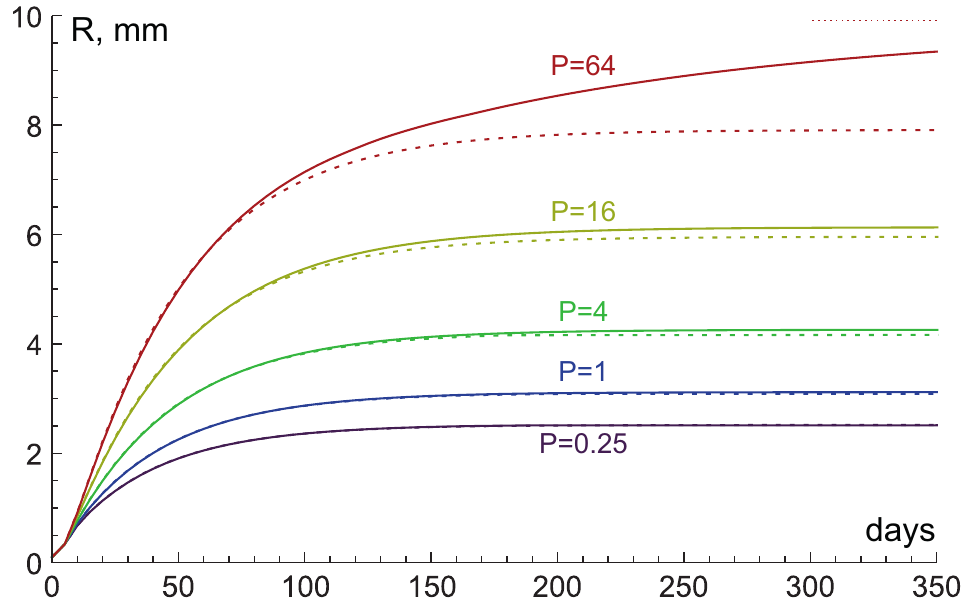
Figure 6. Tumor growth curves, produced by numerical simulations of the system of Equation (6) under different nutrient supply levels P and tissue hydraulic conductivity K / µ = 0.3 (solid lines) and K / µ = 3 (dashed lines). Red dotted line denotes the limit value of tumor radius under K / µ = 0.3 and P = 64.